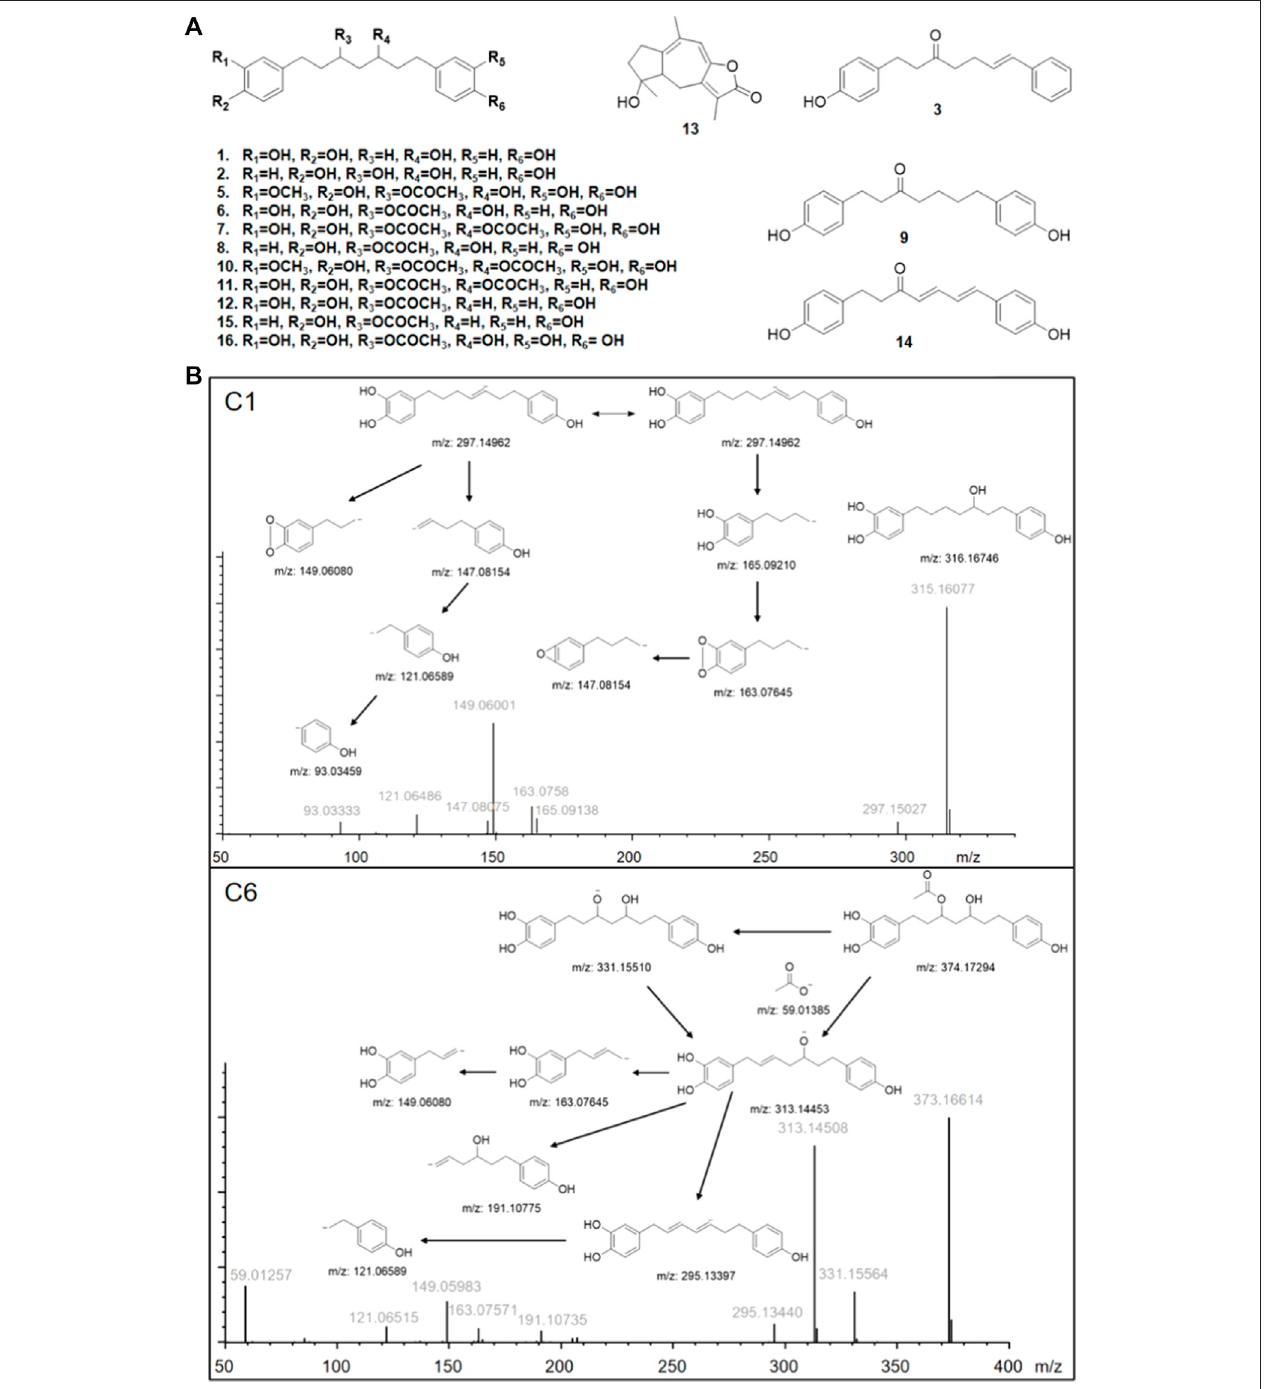
FIGURE2|(A) Structuresofidenti fi edbioactivecompoundsin Curcumae Rhizoma; (B) ProposedfragmentationpathwaysofC1andC6innegativeionmode.m/z represents the calculated theoretical mass value of the fragments; gray font represents the actual value of the measurements.